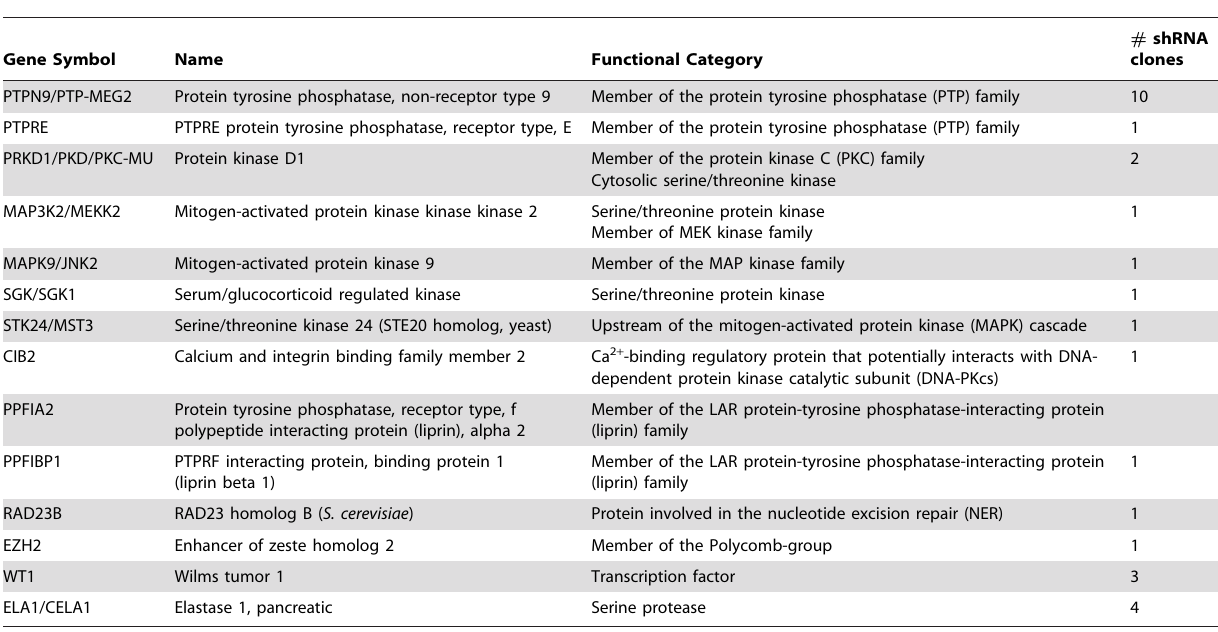
Table 1. Proteins identified in the shRNA screen important for HIV-1